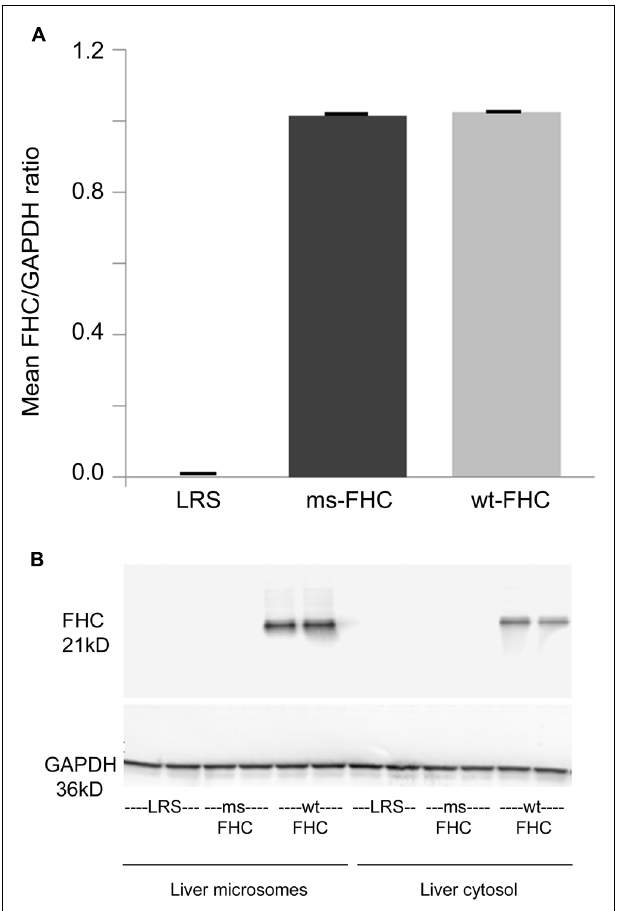
FIGURE 1 | Human ferritin heavy chain (FHC) expression is increased in transgenic sickle mice. NYDD1 sickle mice were injected hydrodynamically with Sleeping Beauty ( SB) transposase vector with either a wild-type (wt) human fTH-1 gene or a triple missense (ms) fTH - 1 gene devoid of ferroxidase activity. Control NY1DD sickle mice were infused hydrodynamically with lactated Ringer’s solution (LRS). 8 weeks after hydrodynamic infusion, the spleens and livers were removed and flash frozen. (A) Total mRNA ( n = 4 mice/treatment group) was isolated from the spleens and transcription of the human wt- and ms-fTH transgene mRNA was demonstrated by qRT-PCR, values are expressed as mean + SD of the ratio of FHC to GAPDH mRNA. (B) Western blots of liver microsomes and cytosol from treated sickle mice were immunostained for FHC expression. Note that because the third mutation at residue 86 is in a loop section suspected to be a conformational epitope (Addison etal., 1984), it is likely that our primary anti-FHC antibody did not bind our triple ms-hFHC protein on western